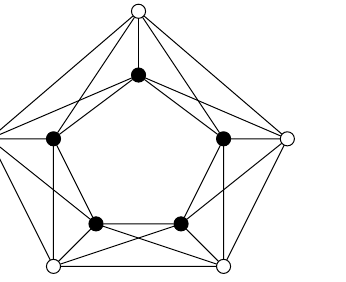
( G ) = 2 n n − δ − 1 2 t